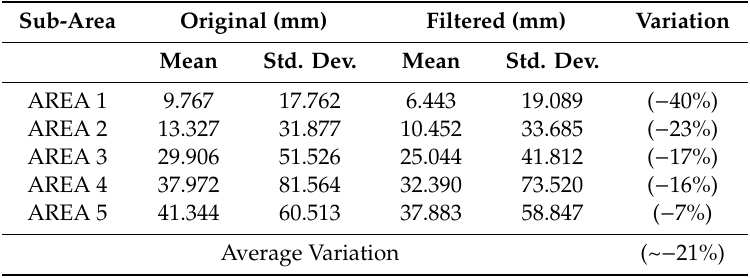
Table 7. Cloud-to-cloud distance analyses between the laser scanning and the photogrammetric point clouds derived from the original and filtered results.